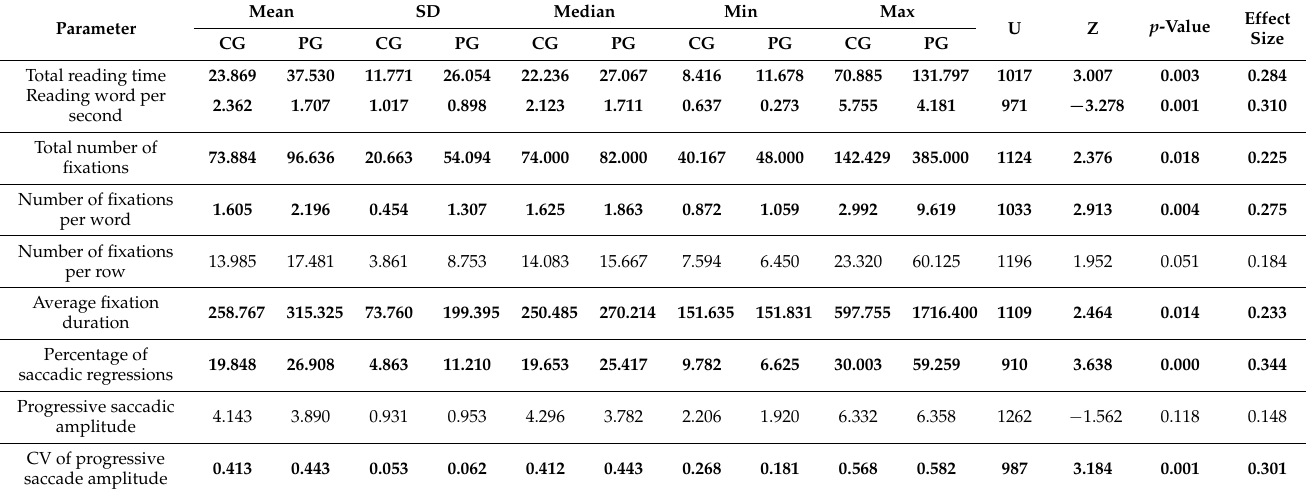
Table 1. The parameters of eye movements during reading, averaged over all seven texts, in the control group (CG) and in the group of children who survived cerebellar tumor (PG). Values in bold indicate statistically significant